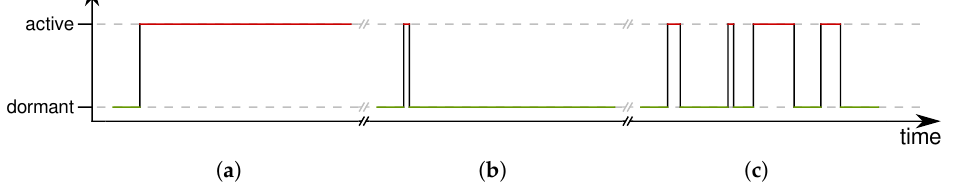
Figure 6. Fault categorization based on their persistence. ( a ) permanent/solid fault, ( b ) transient fault, ( c ) intermittent